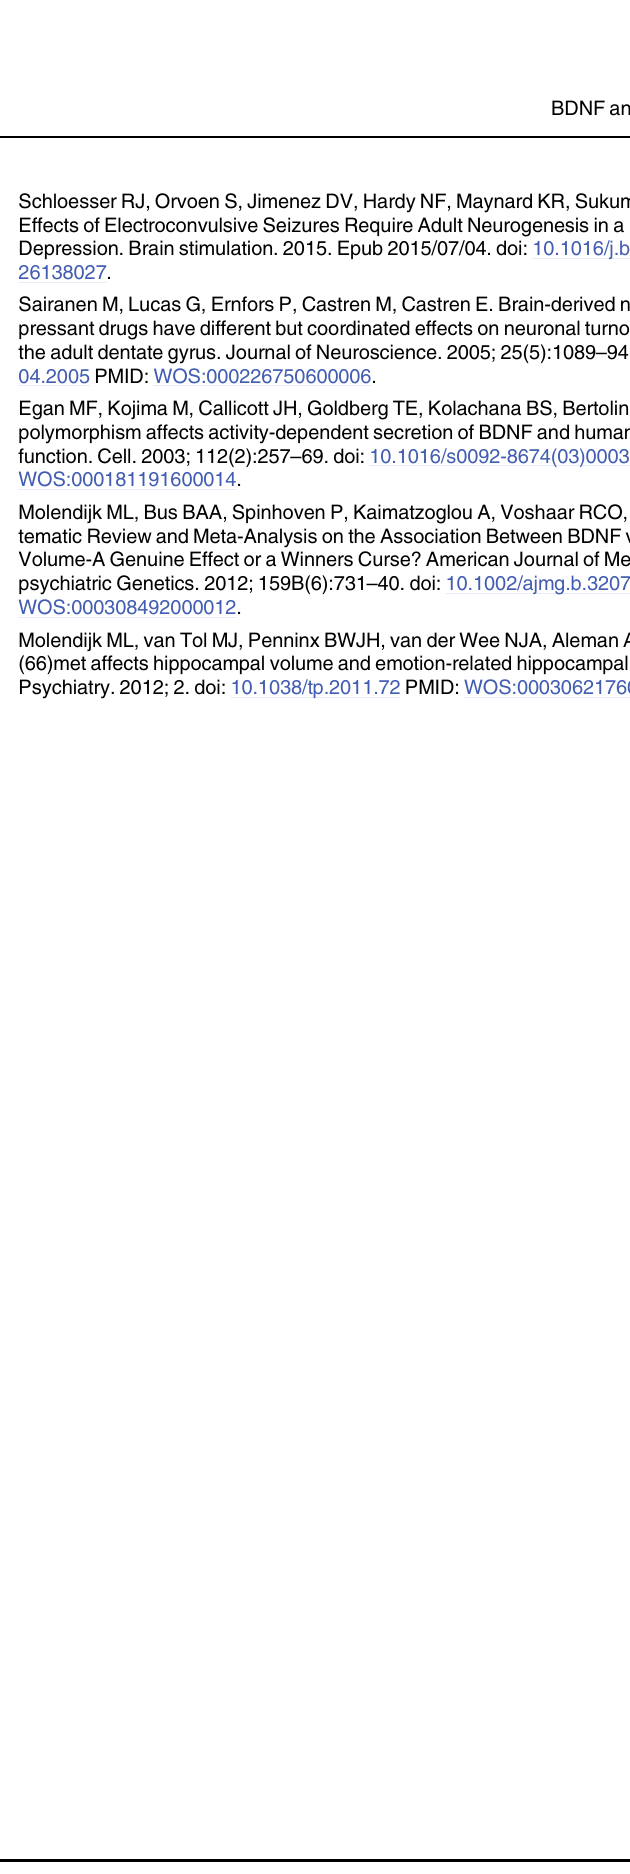
PLOS ONE | DOI:10.1371/journal.pone.0141564 November 3,